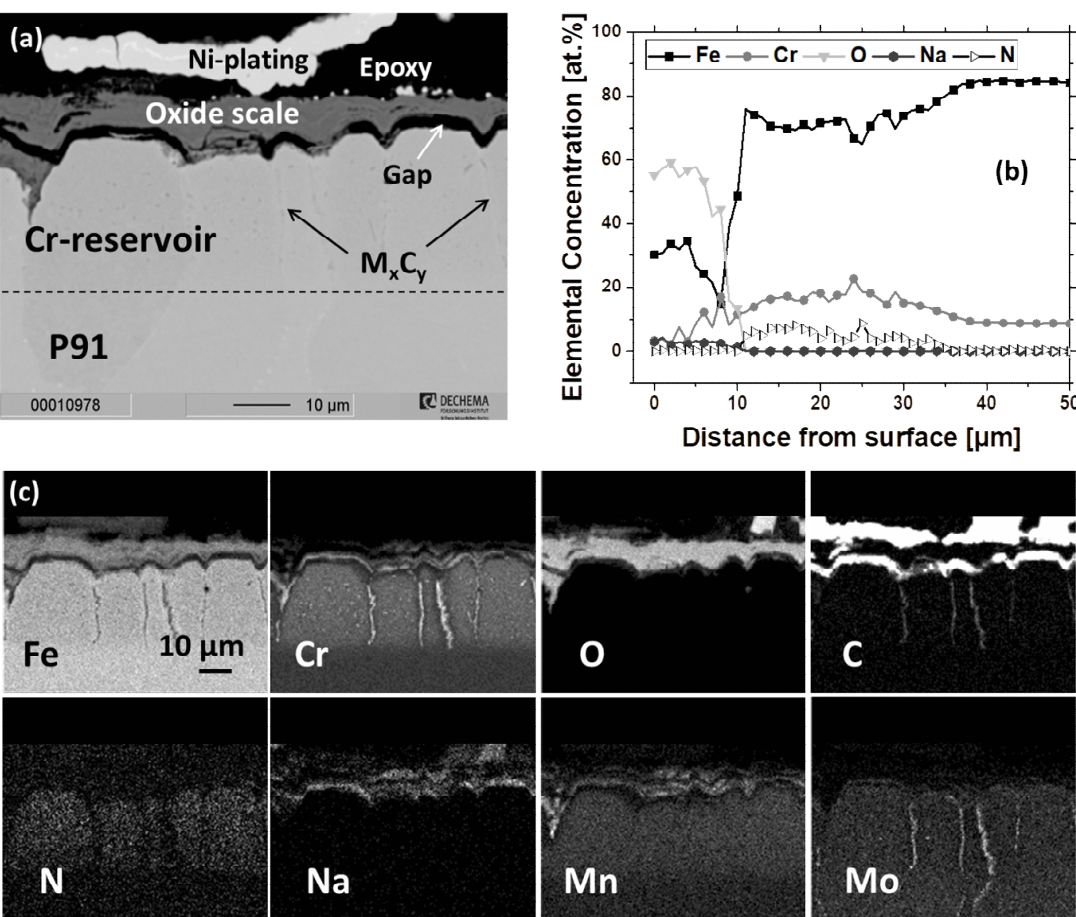
Figure 8. ( a ) Cross-sectional BSE-image, ( b ) quantitative line scans of Fe, Cr, O, Na, and N, and ( c ) elemental distribution maps of chromized P91 after 1000 h isothermal exposure in molten solar salt at 600 ◦